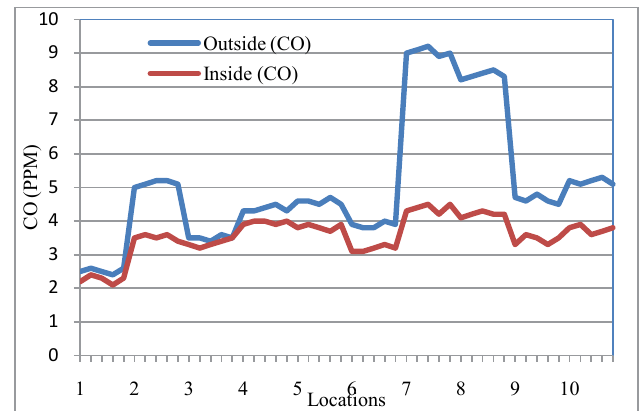
Fig. 3: Monitored CO Concentration Inside and Outside of Houses 10 Locations in the Study Area